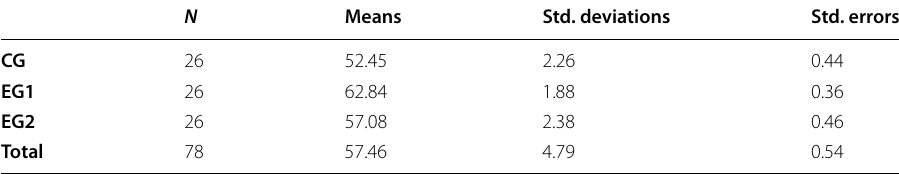
Table 3 Descriptive statistics: the participants’ post-test of speaking fluency scores N Means Std. deviations Std. errors